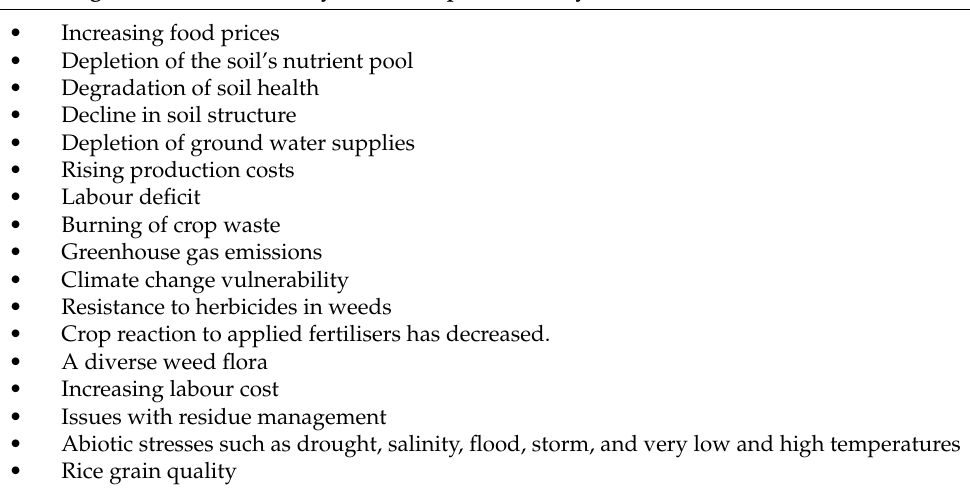
Table 6. Challenges to the sustainability of the rice production system and suggested proposed solutions